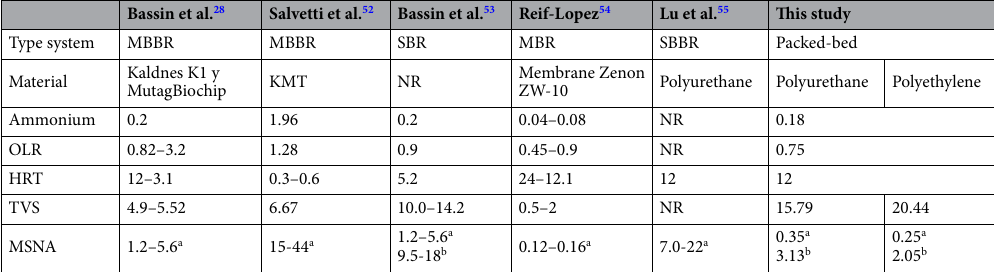
Table 3. Specific nitrifying activity obtained in different laboratory-scale studies. a Fixed biomass, b Suspended biomass. Where: Maximum specific nitrifying activity (MSNA) is expressed in mg NH 4+ -N/g TVS∙h; Volumetric organic load rate (OLR): kg COD∙m 3 /d; Ammonium load: kg NH 4+ -N/m 3 ; Hydraulic retention time (HRT): h; Total volatile solids (TVS): g/L. NR no